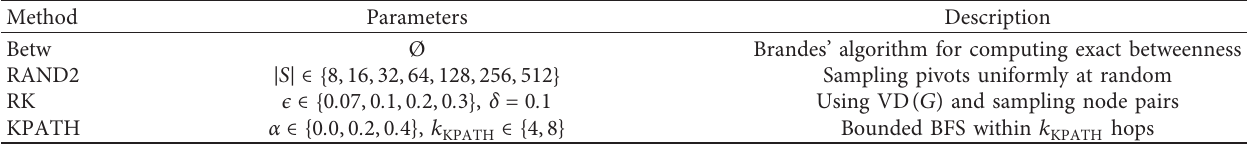
Table 5: Overview on the selected methods of betweenness approximation.